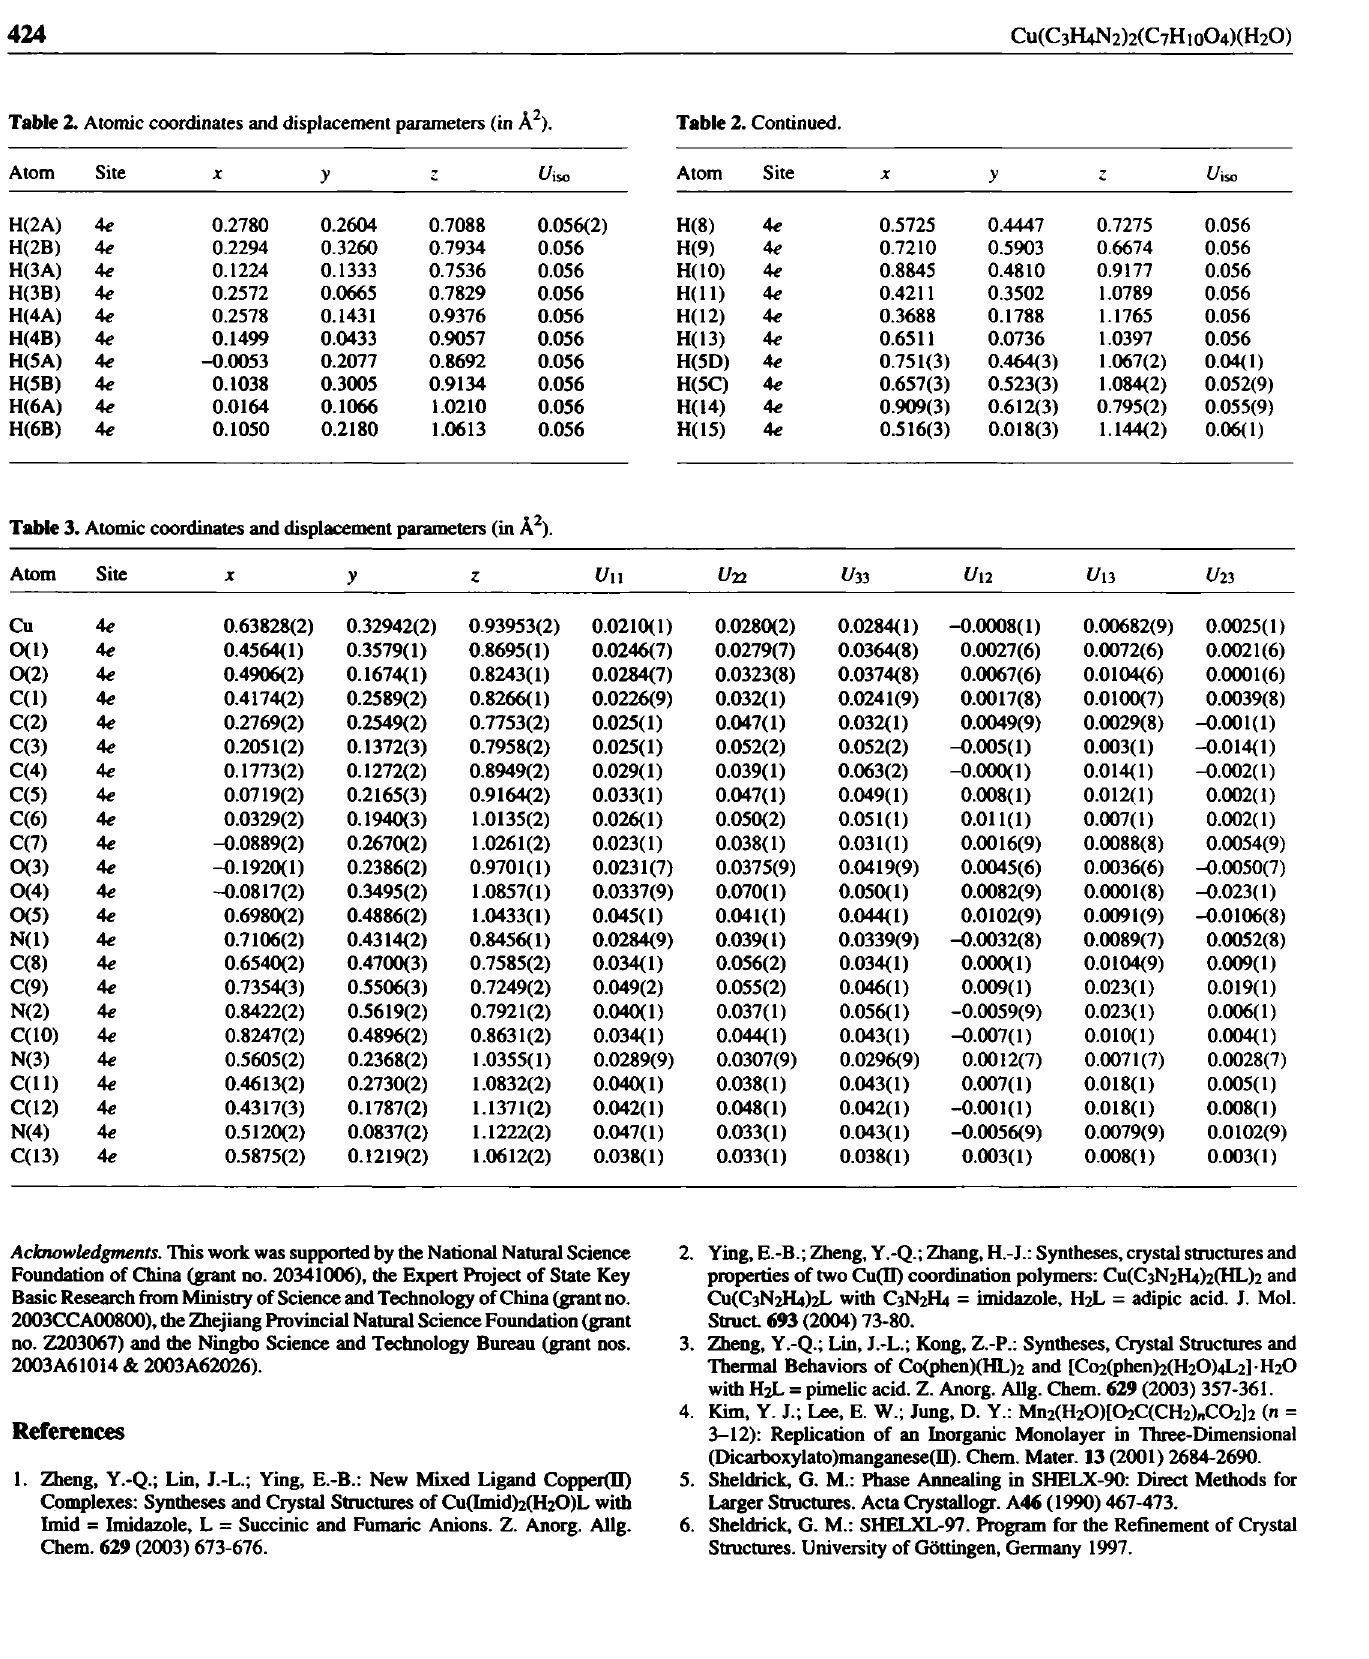
Table 3. Atomic coordinates and displacement parameters (in A 2